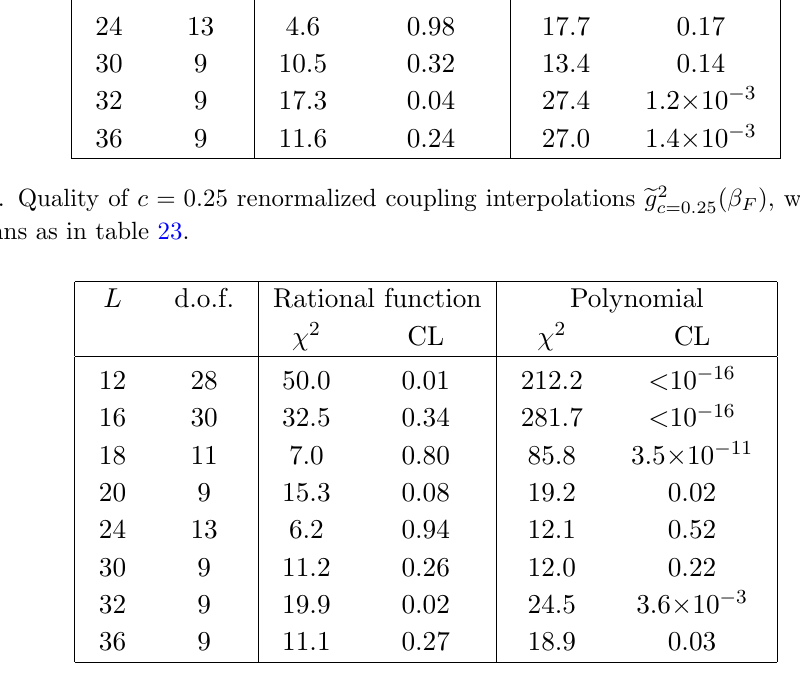
g 2 ( (cid:12) F ), with (cid:28) opt = 0 : 08 e c =0 : 3